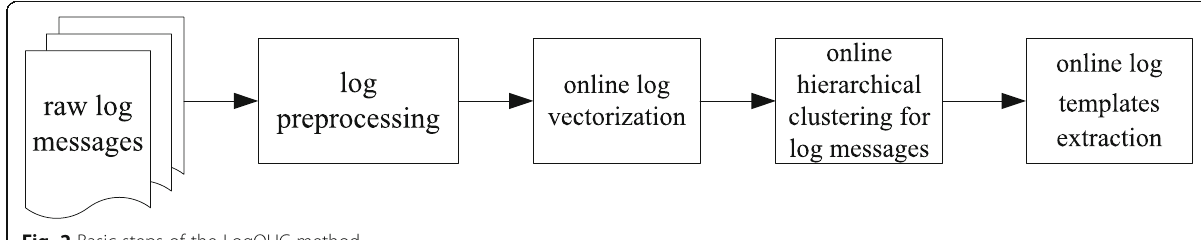
Fig. 2 Basic steps of the LogOHC